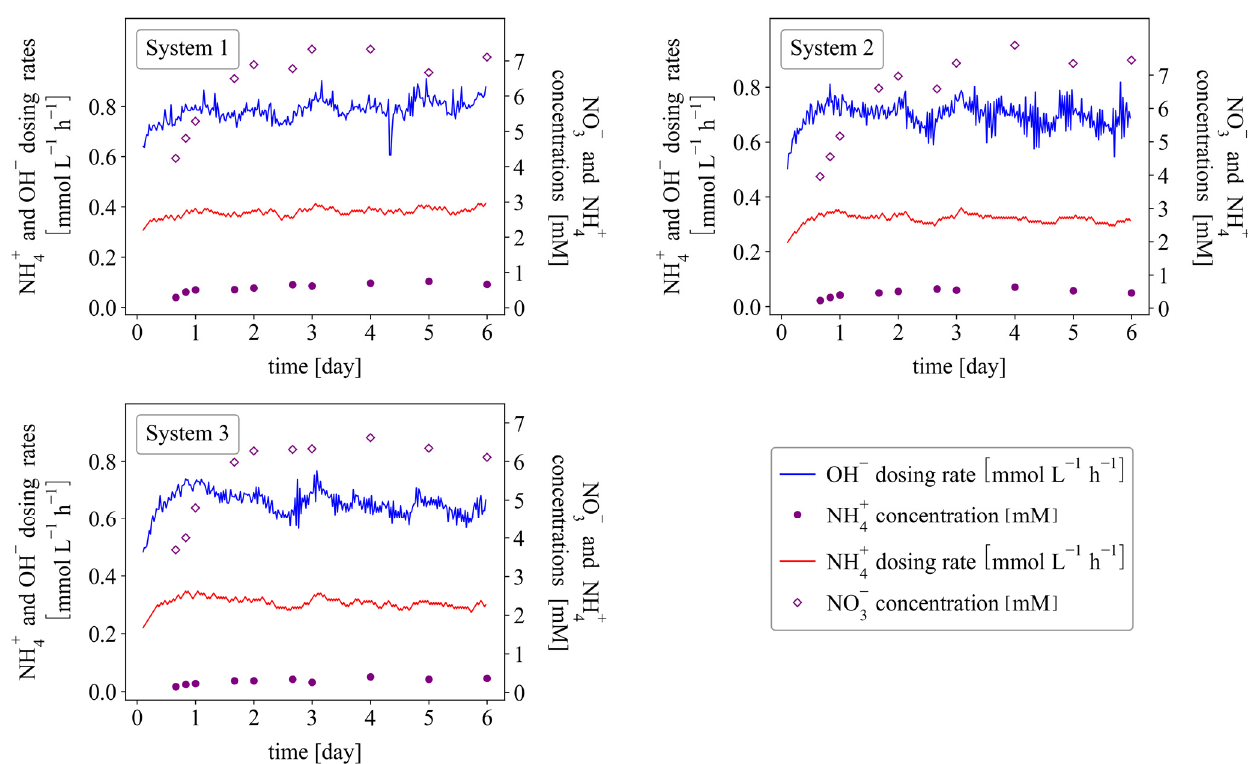
Figure 7. Results from the control strategy shown in Figure 5 employed in a CSTR setup with a dilution rate of 1 day –1 . Hydroxide dosing rates are shown as blue lines and the ammonium dosing rates are show as red lines. The ammonium and nitrate concentrations in solution were measured and are shown as purple dots and diamond markers, respectively.